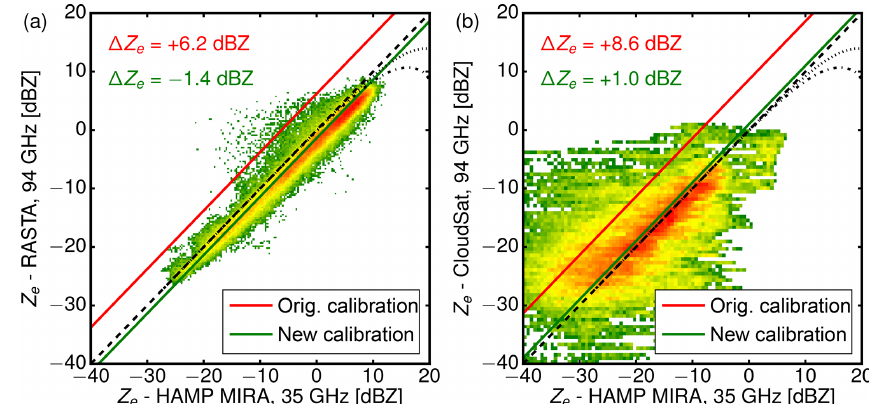
Figure 13. (a) Comparison of effective reflectivities shown in Fig. 12 measured with HAMP MIRA at 35GHz and the airborne RASTA instrument at 94GHz. (b) Comparison of effective reflectivities shown in Fig. 14 measured with HAMP MIRA at 35GHz and the spaceborne CloudSat instrument at 94GHz. In both cases, common coordinates were used as reference points to obtain reflectivity pairs from both instruments. The green line shows the offset fit for the new calibration, the red line for the old HAMP MIRA calibration. The linear regression reveals lower reflectivities ( − 1 . 4dB) for RASTA but slightly higher reflectivities ( + 1 . 0dB) for